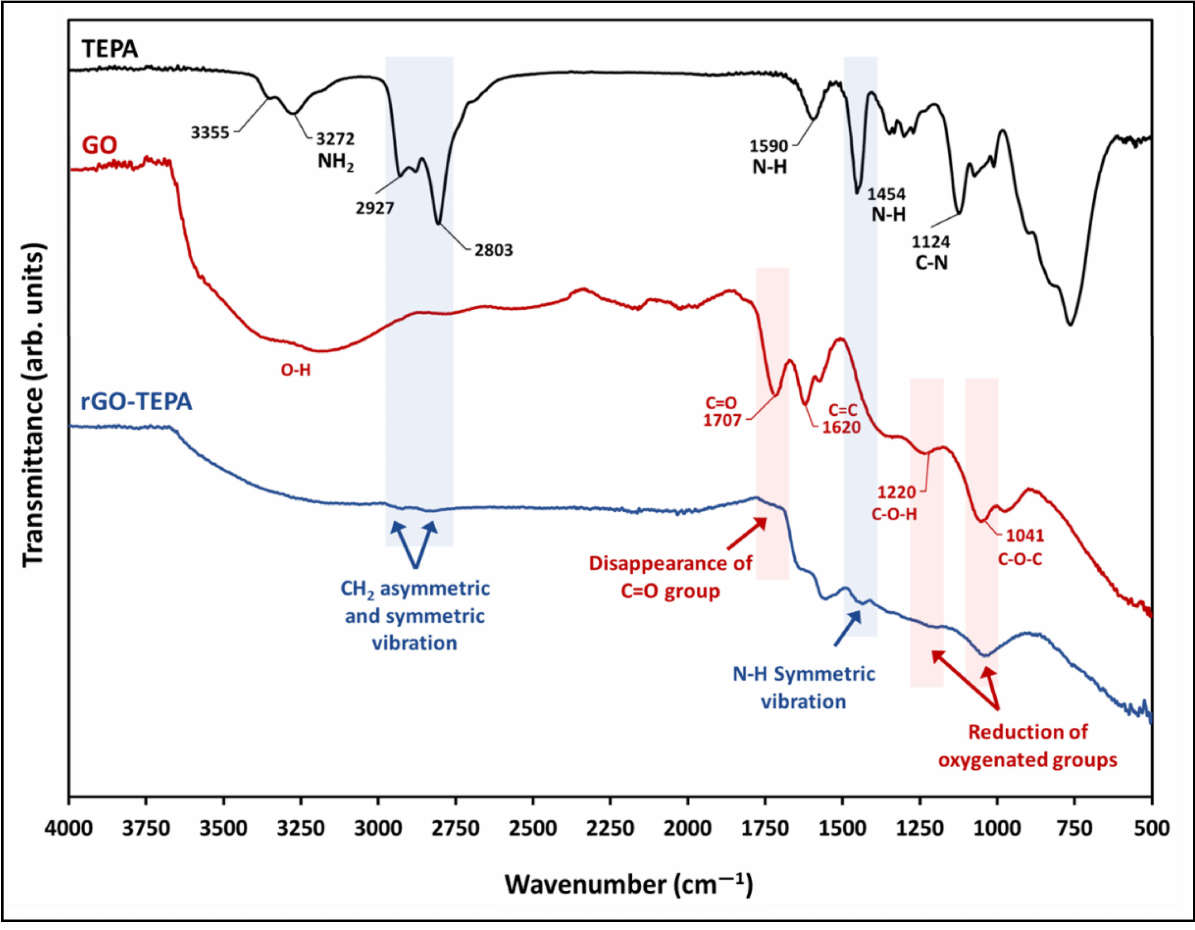
Figure 2. FTIR-UATR spectra of TEPA, pristine GO, and rGO-TEPA